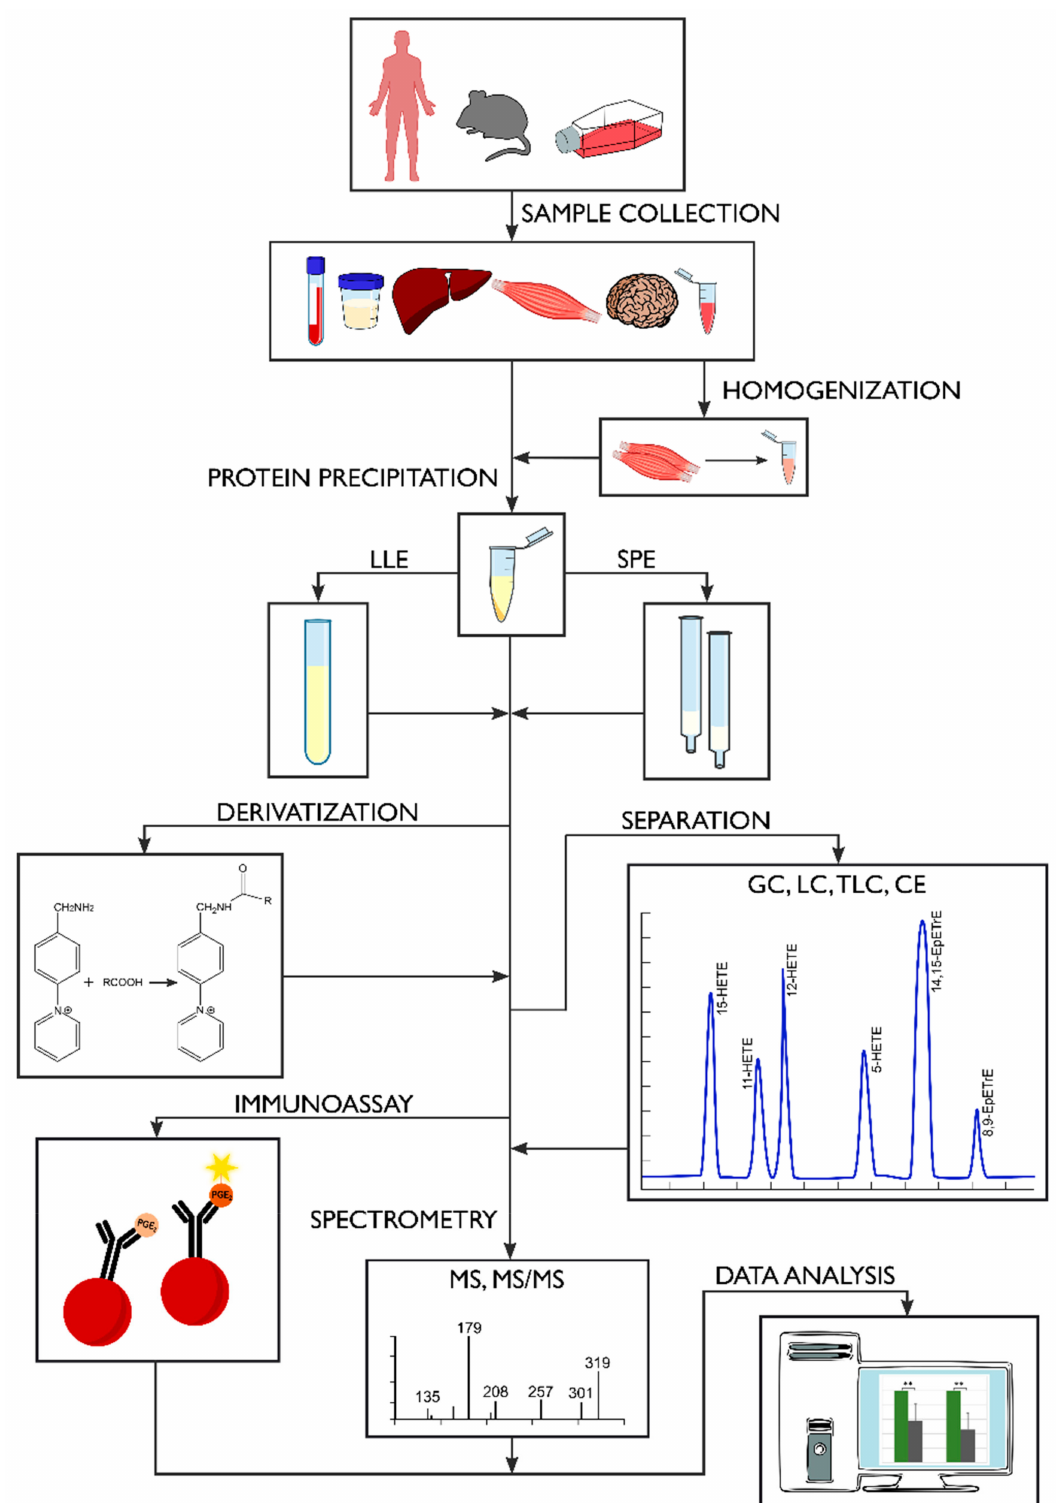
Figure 4. Scheme of the complete analytical procedure of